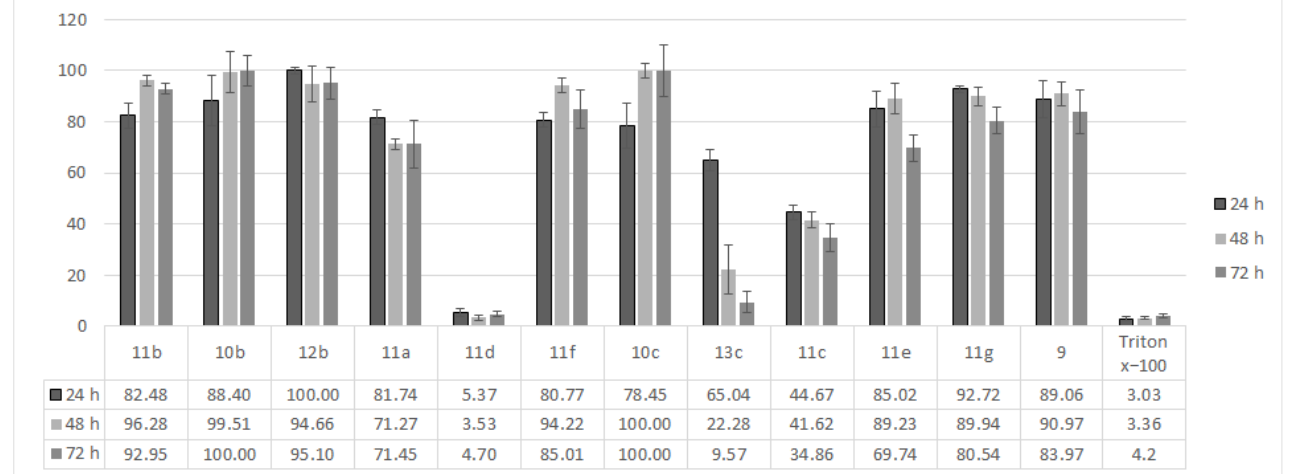
Figure 8. Cell viability (%) of normal human dermal fibroblasts (HDF) exposed to the tested com- pounds at a concentration of 50 μ M assessed with a use of MTT assay.